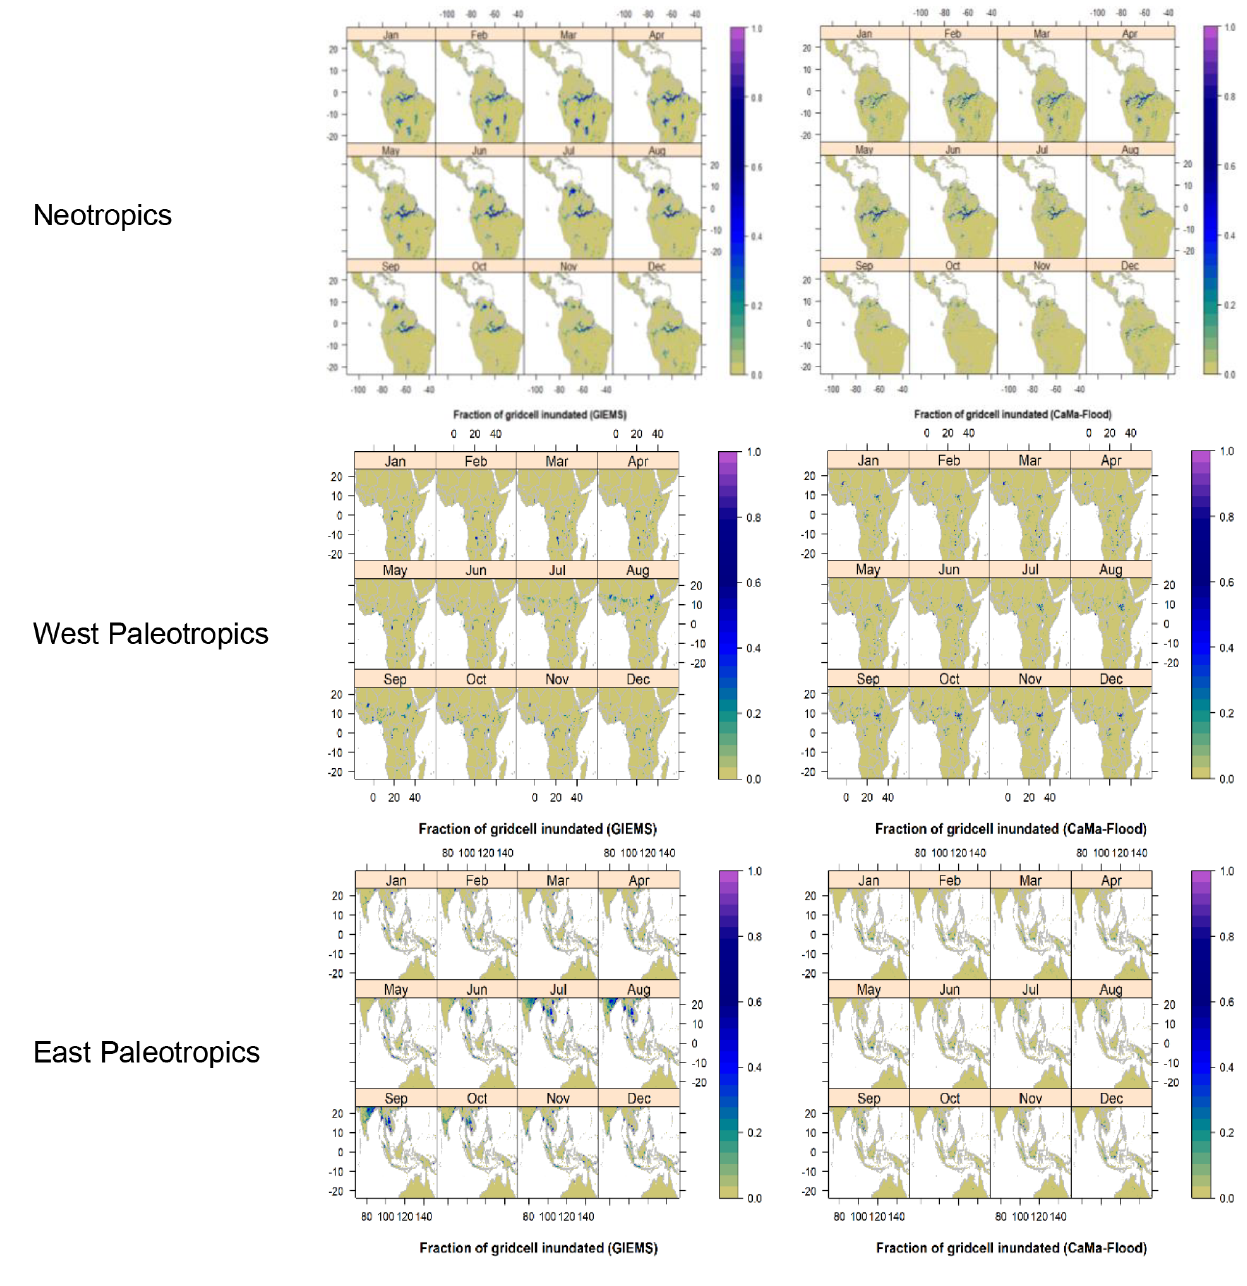
Figure 3. Fraction of grid cells inundated (in addition to water contained in channels and watercourses, which are not shown) in each study area. Superposed lakes and reservoirs are from the Global Lakes and Wetlands Database, GLWD (Lehner and Döll, 2004). Resolution is 0.25 ◦ in both latitude and longitude (NB: Tonlé Sap is our smallest wetland, and therefore the grid cells are relatively large in that plot). View window extent is taken from references in Table 1. Cities with populations > 100000 are shown (SimpleMaps, 2019) for view extents up to 2000000km 2 . Data shown are an average for 1992–2014 from GIEMS-2 observations (left-hand-side panels) and equivalent JULES- CaMa-Flood simulations (right-hand-side